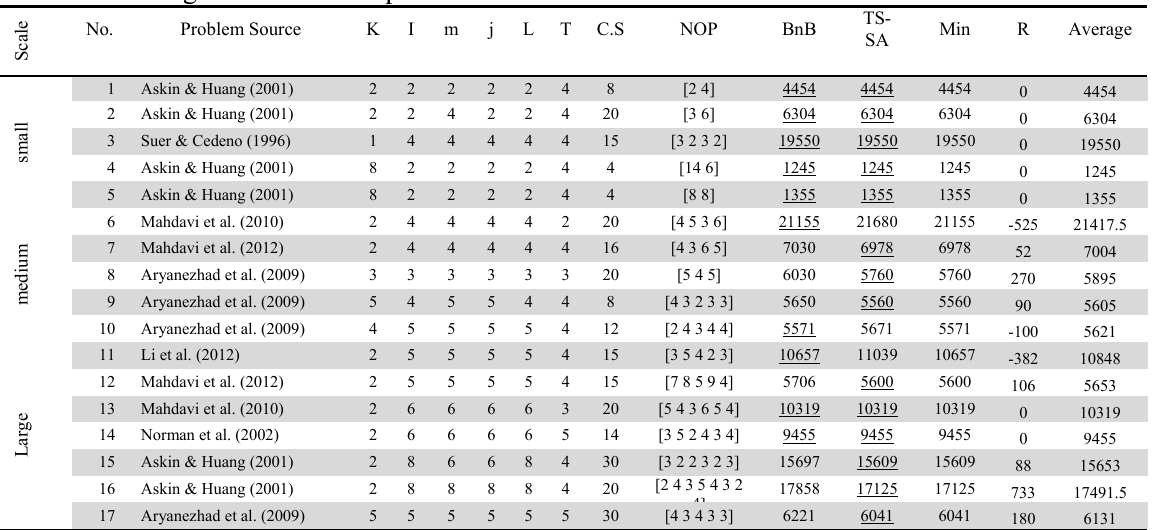
Fig. 11. The objective function graph of TS-SA method for experiment number 8 in Table 9